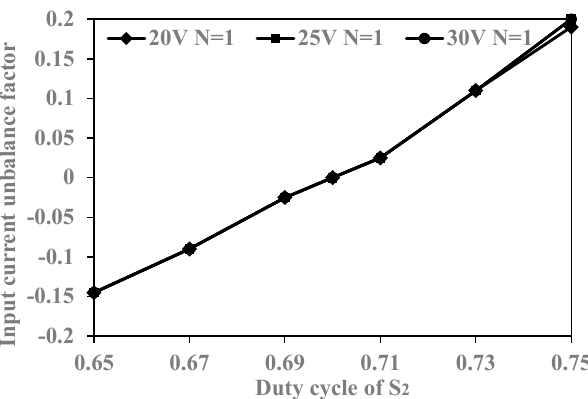
Figure 8. Input current auto-balance performance under asymmetrical duty cycle.